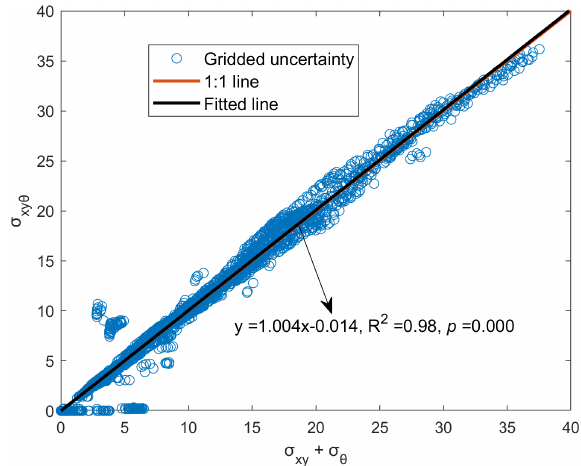
Figure 9. The relationship between the summation of predictive un- certainty from data (input and target data) and model and the pre- dictive uncertainty from joint consideration of data (input and target data) and model.